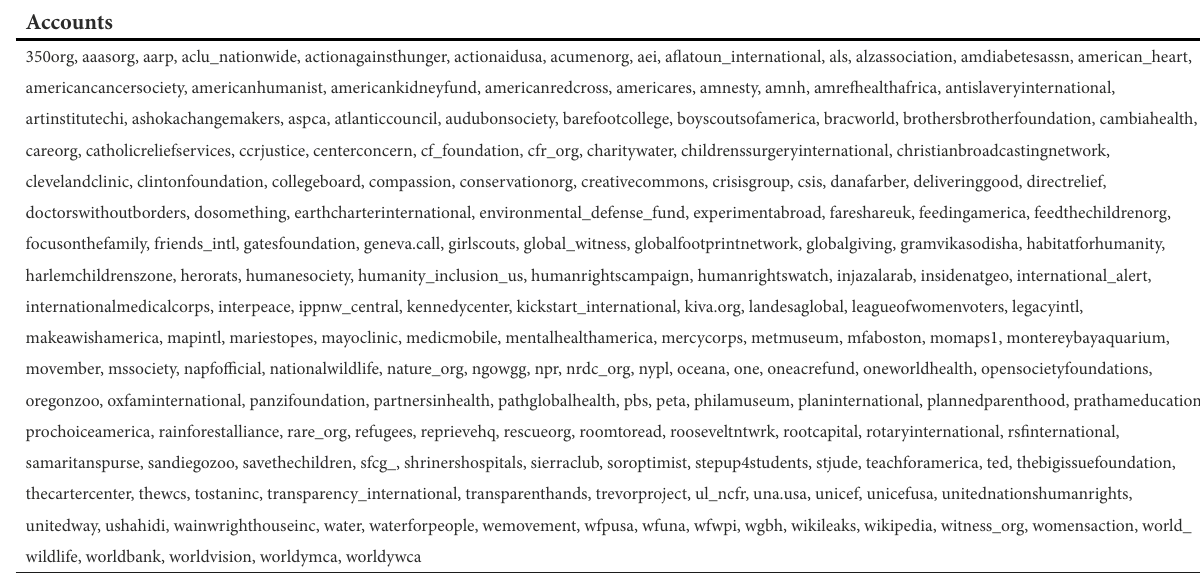
TABLE 1 Instagram accounts of nonprofit organizations in the research